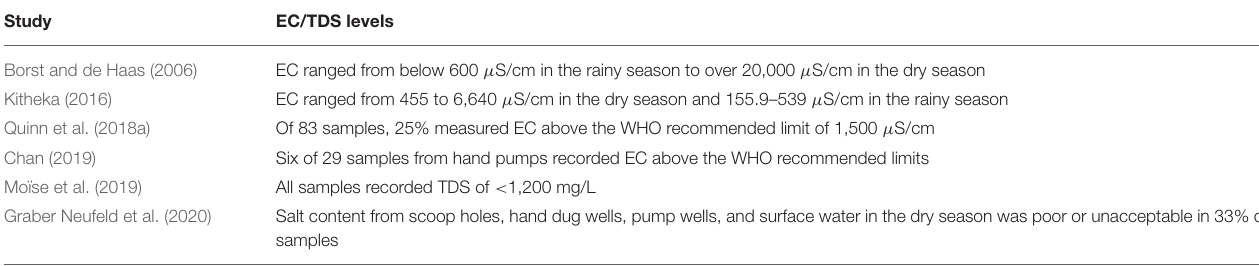
TABLE 3 | Levels of EC/TDS measured in different studies. Study EC/TDS levels